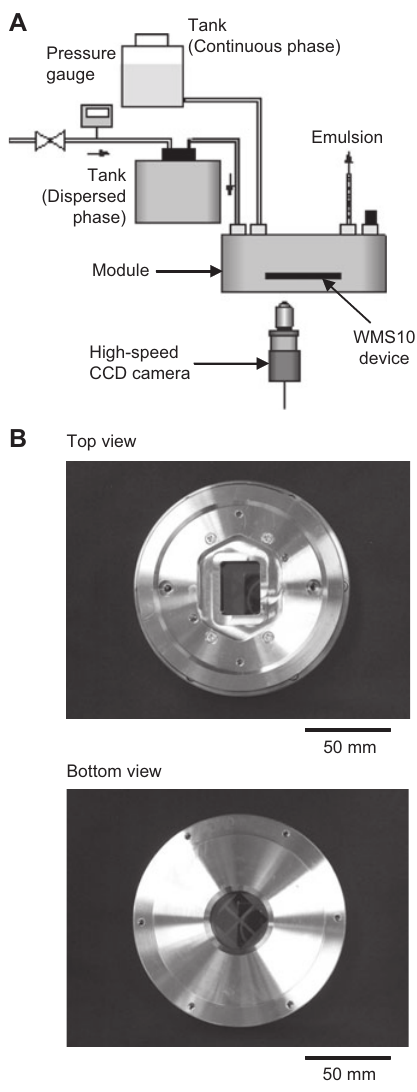
Figure 3 (A) Simplified schematic drawing of the large MC emulsifi- cation device developed in this study. (B) Top and bottom views of the